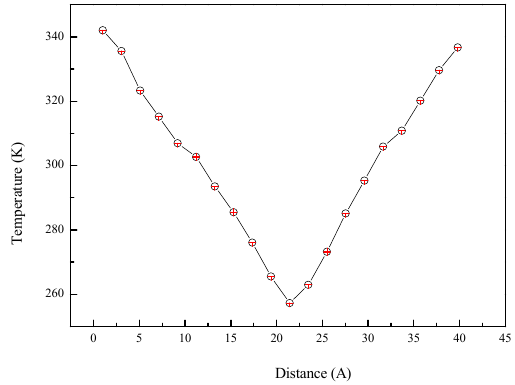
Figure 9. Temperature profile of system (a) (128 n -octadecane molecules) in NEMD simulation with an average system temperature of 305 K.